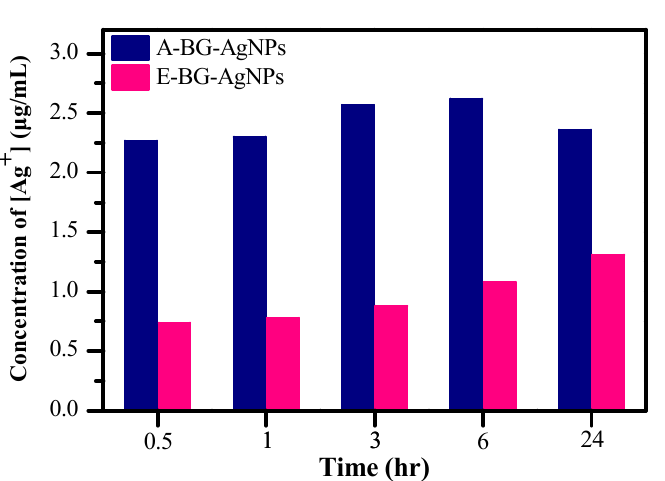
Figure 8. AAS measurements for the release of Ag ions from A-BG-AgNPs and E-BG-AgNPs at different incubation times, respectively.